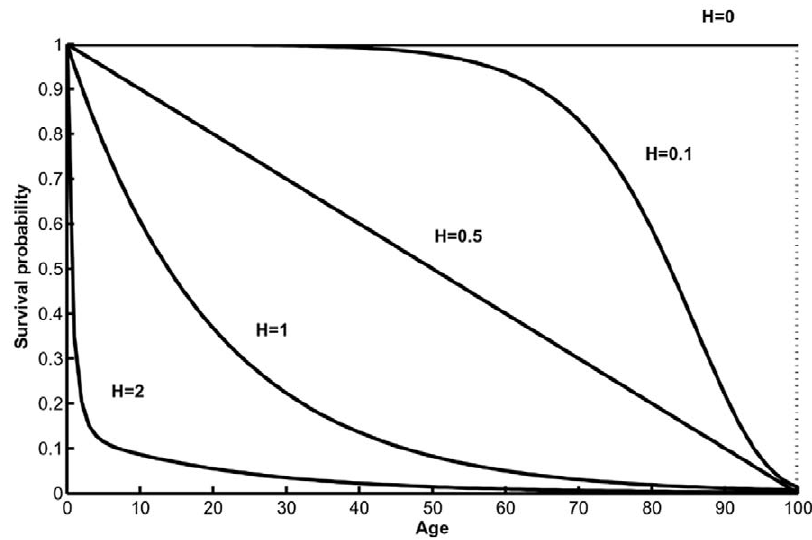
Figure 3. Hypothetical survivorship curves for different values of H, entropy.